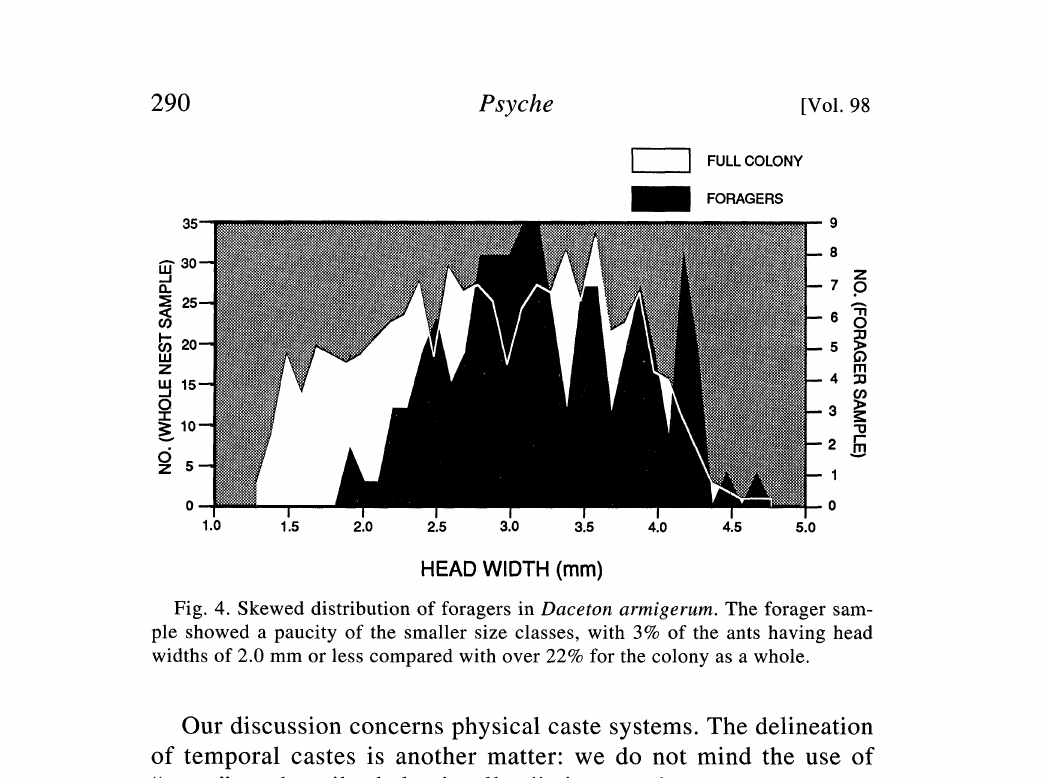
Fig. 4. Skewed distribution of foragers in Daceton armigerum. The forager sam- ple showed a paucity of the smaller size classes, with 3% of the ants having head widths of 2.0 mm or less compared with over 22% for the colony as a